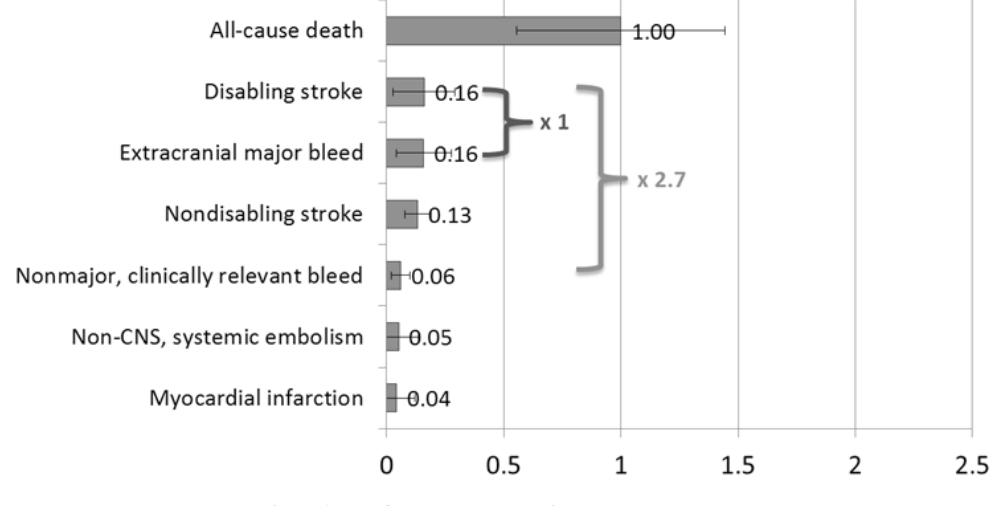
Figure 3. Physician Importance Weights (n = 164) Importance weights normalized relative to all-cause death and 95% confidence interval corresponding to a 3-percentage- point change in the incidence of each event. Apart from all-cause death, all events are non-fatal